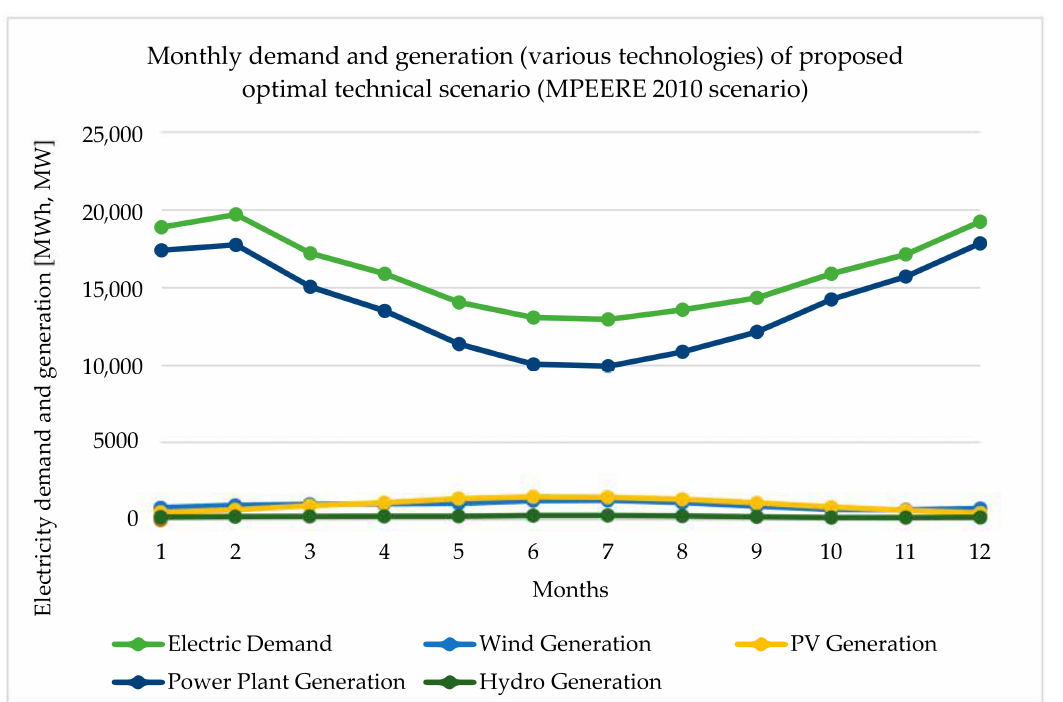
Figure 11. Monthly demand and generation of proposed optimal technical scenario (MPEERE 2010